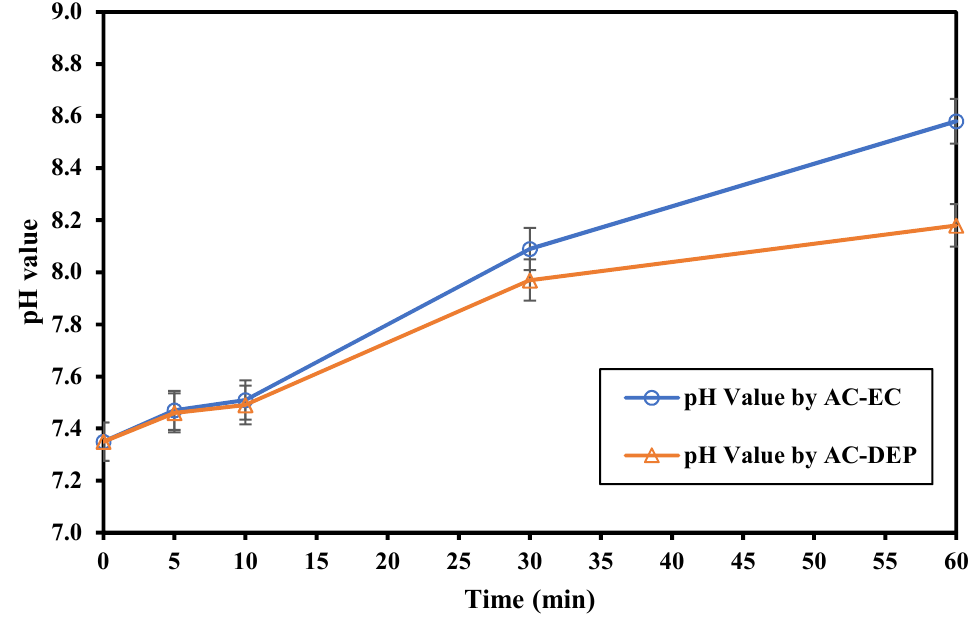
Figure 9. The pH values using variable electrolysis time, electrode spacing 0.5 cm and applied current 800 mA.